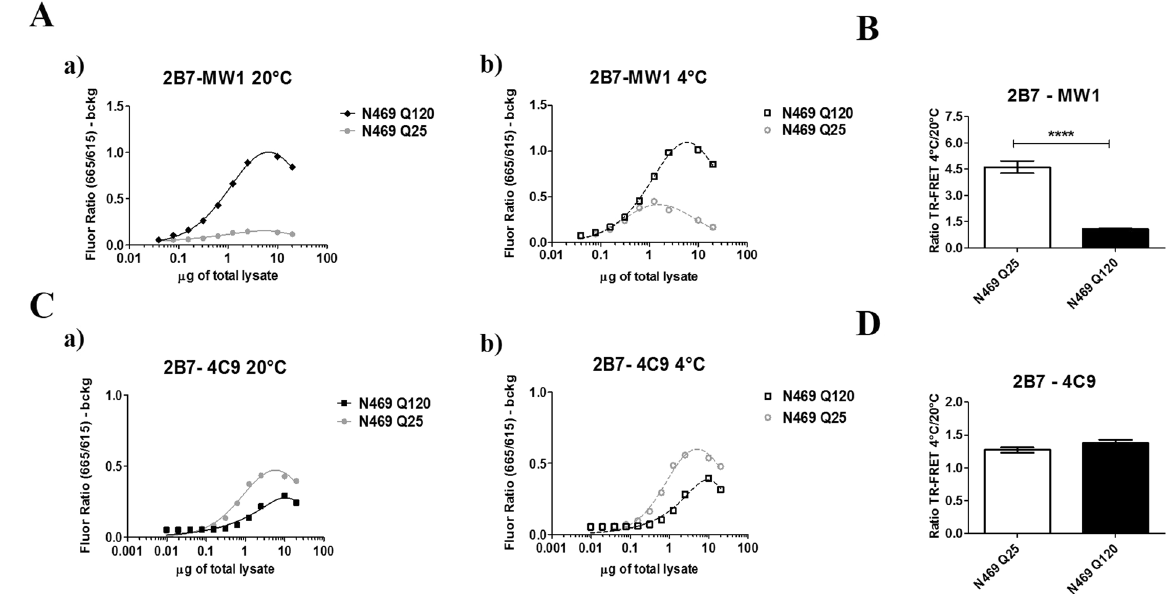
Figure 6. The 2B7/MW1 conformational immunoassay detects mHTT conformation in a Drosophila transgenic HD model. ( A ) The 2B7/MW1 TR-FRET assay performed on tissue homogenates of flies expressing a human wild type HTT N469 fragment or a mHTT N469 fragment at 20 °C (a) or measured after shifting the same samples to 4 °C (b). ( B ) Summary of data (ratio TR-FRET signals at 4 °C/20 °C) from three independent experiments. ( C ) Same as A, obtained on the same samples using a (control) TR-FRET immunoassay (2B7/4C9) which does not interrogate the polyQ region and does not detect a temperature- and polyQ dependent conformational change 11, 12 , demonstrating efficient detection of all proteins. ( D ) Same as B (ratio TR-FRET signals at 4 °C/20 °C) obtained on the same samples using a (control) TR-FRET immunoassay (2B7/4C9) which does not interrogate the polyQ region and does not detect a temperature- and polyQ dependent conformational change. In B and D values represent means and standard deviations of the means of three independent experiments (Datasets were tested for normality and Student’s t-test, degrees of significance are